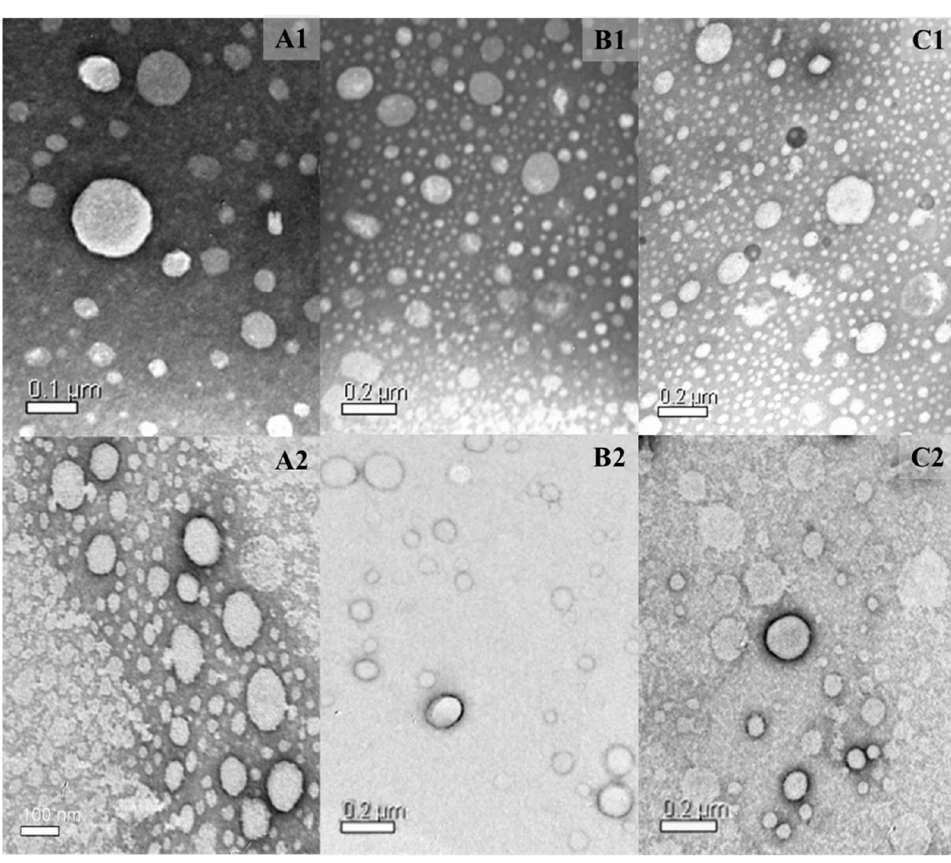
Figure 1. TEM images of the nanoparticles of NLC/RFV: R 1 -8-QO-Pt-NLC ( A1 ), R 1 -NLC ( A2 ), R 2 -8- QO-Pt-NLC ( B1 ), R 2 -NLC ( B2 ), R 3 -8-QO-Pt-NLC ( C1 ), and R 3 -NLC ( C2 ). R 2 -8-QO-Pt-NLC ( B1 ), R 2 -NLC ( B2 ), R 3 -8-QO-Pt-NLC ( C1 ), and R 3 -NLC ( C2